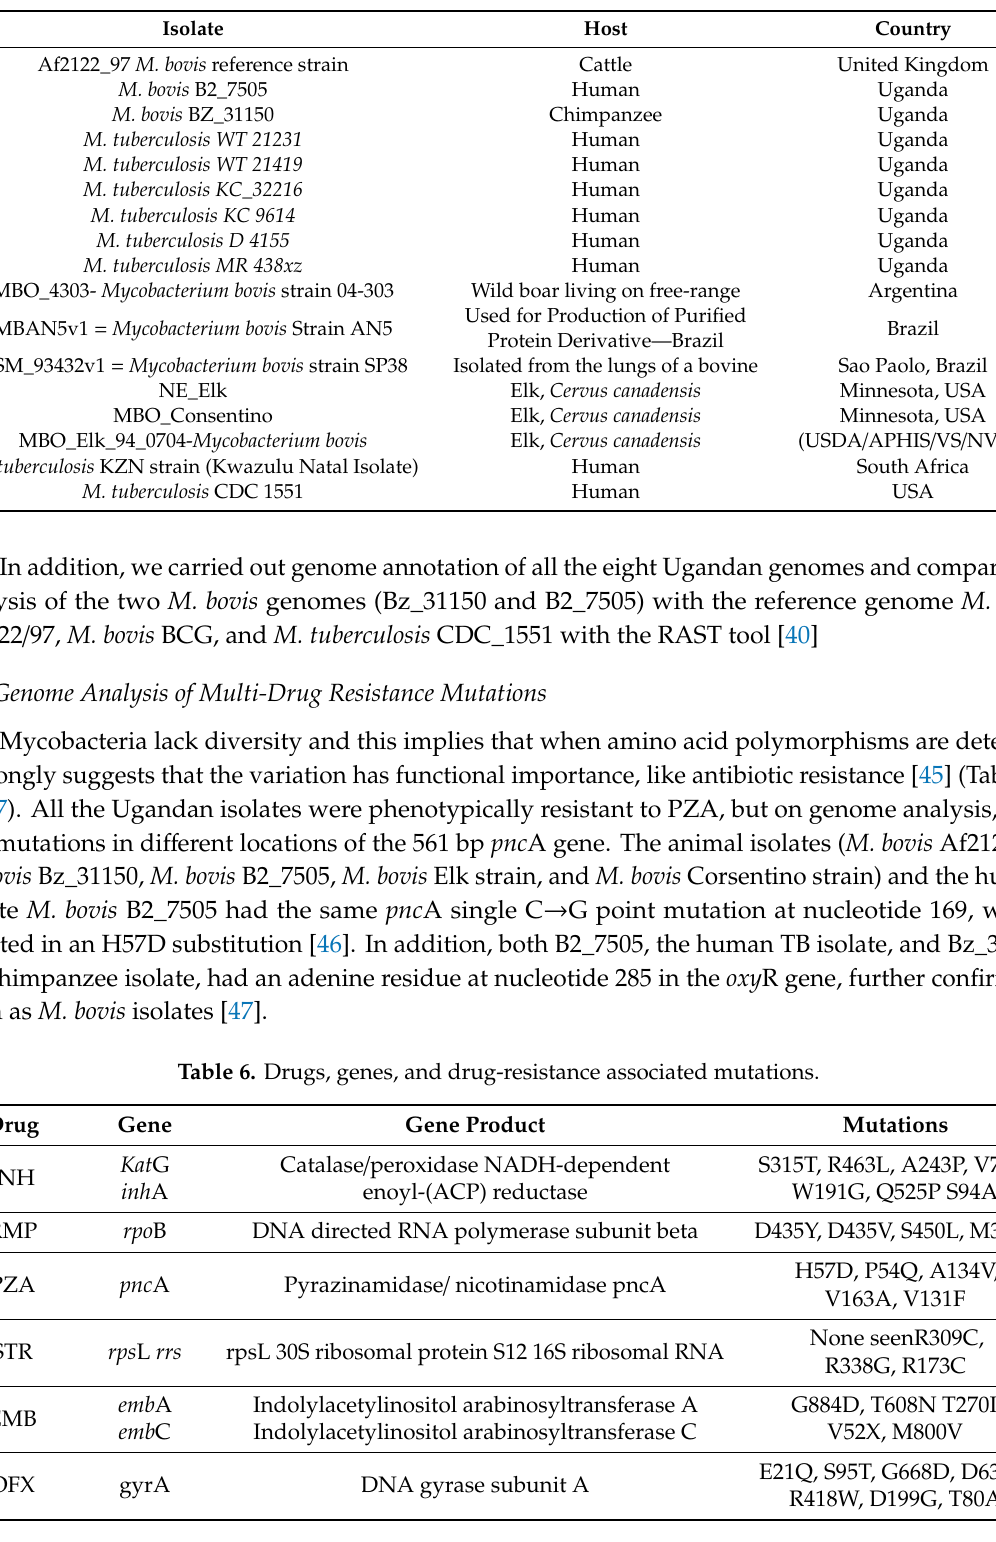
Table 5. Global isolates used for phylogenetic analysis.